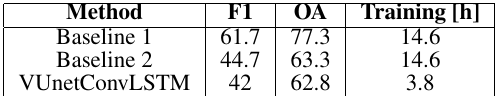
Table 4. Performance metrics averaged over the temporal sequence, and training